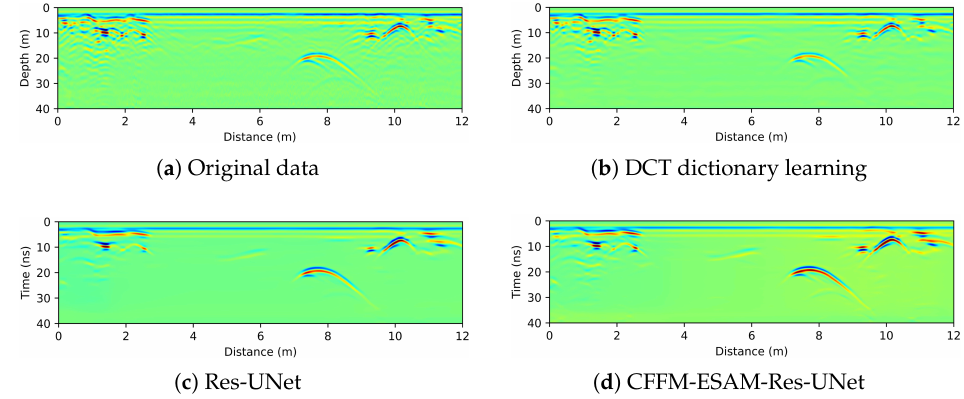
Figure 16. Clutter-removal results of different methods used on a real GPR